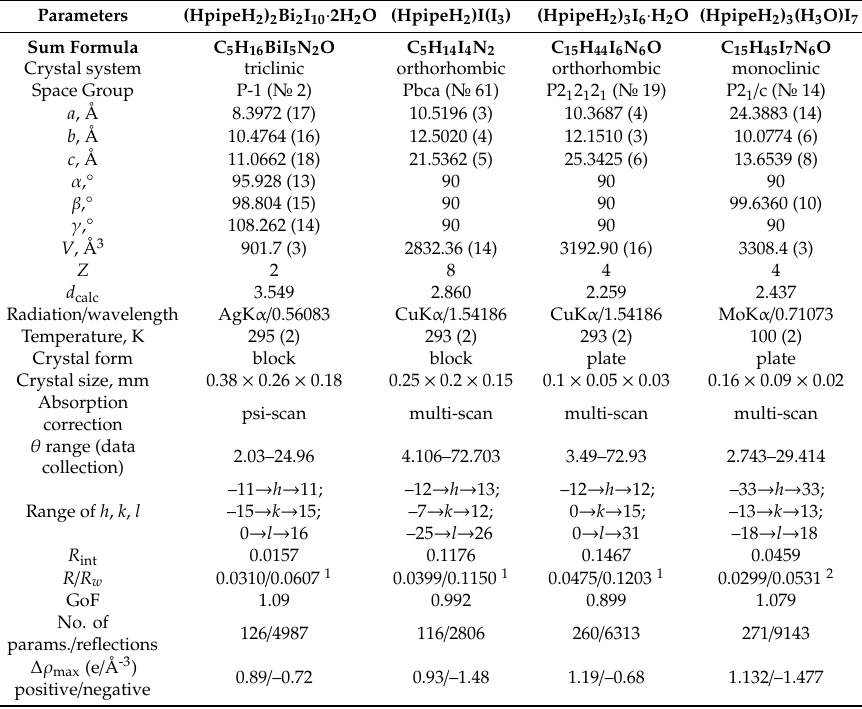
Table 1. Selected interatomic distances are given in Table 2, with hydrogen bonding in Table 3. Table 1. Structure Refinement Parameters.